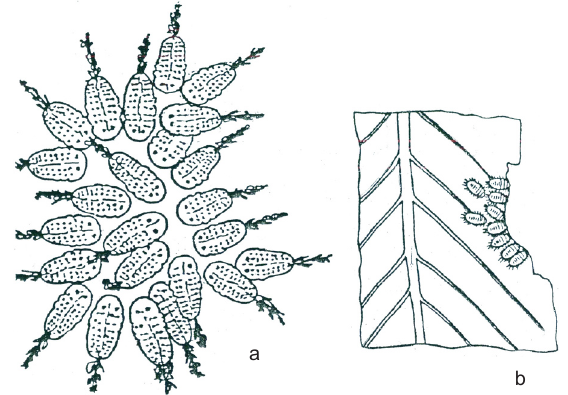
Figure 2. Last instar larvae of the tortoise beetle Aspidomorpha miliaris. a - The larvae at rest in a cycloalexic arrangement. Exuviae carrying caudal ends of the larvae form the periphery of this ovoid grouping; b - The larvae in a feeding position in a tight row at a margin of an Ipomaoea leaf. (Fg. 2 (b) is based on a figure in Verma